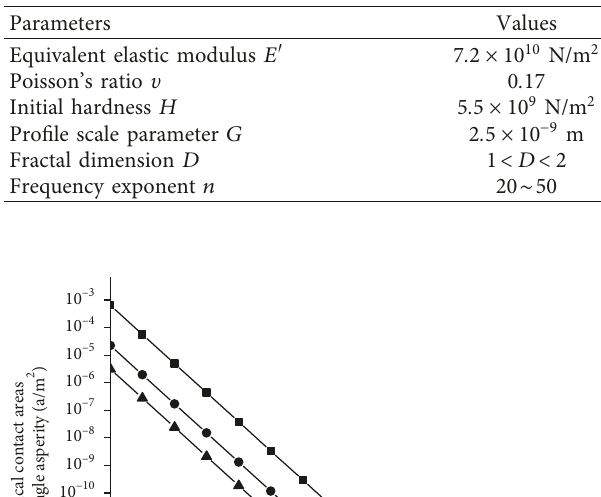
Table 1: The parameters of equivalent joint interface.